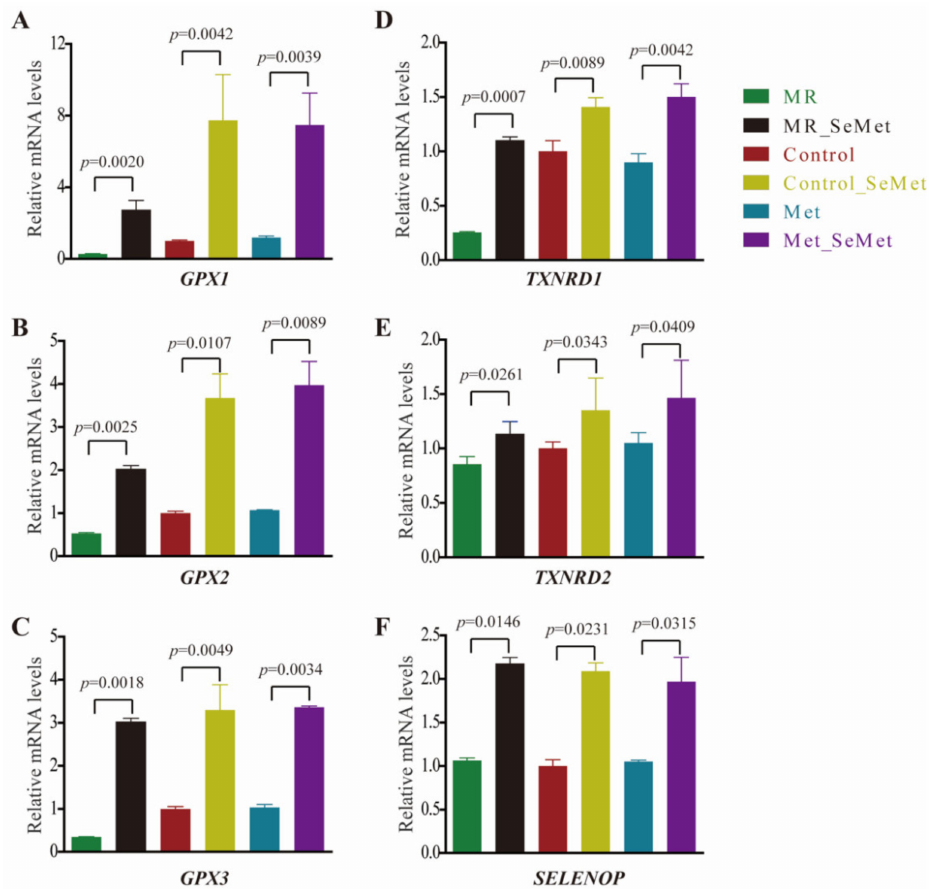
Figure 6. Relative transcriptional levels of selenoprotein genes in HepG2 cells after 48-h exposure of SeMet under different Met supply conditions: ( A ) Relative mRNA levels of GPX1 ; ( B ) Relative mRNA levels of GPX2 ; ( C ) Relative mRNA levels of GPX3 ; ( D ) Relative mRNA levels of TXNRD1 ; ( E ) Relative mRNA levels of TXNRD2 ; ( F ) Relative mRNA levels of SELENOP